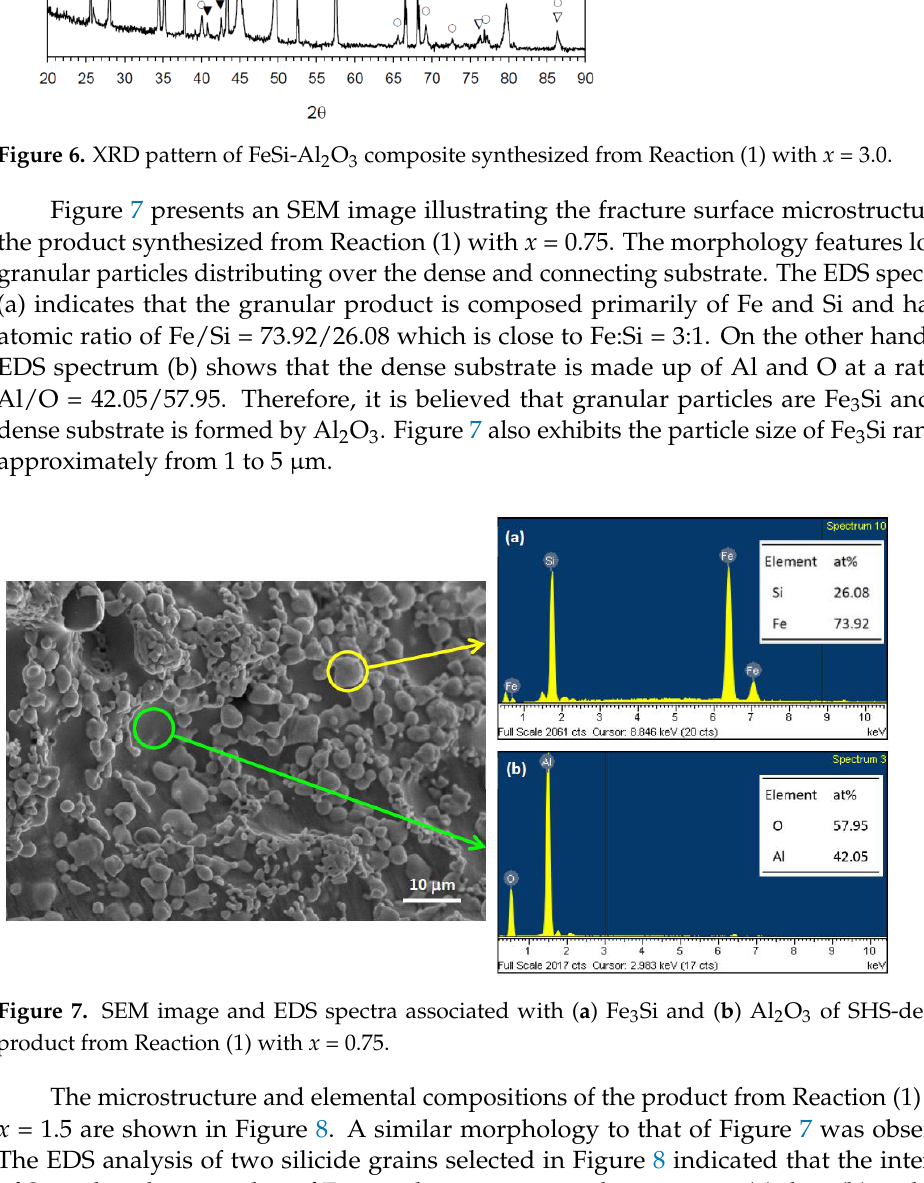
Figure 6. XRD pattern of FeSi-Al 2 O 3 composite synthesized from Reaction (1) with x = 3.0.